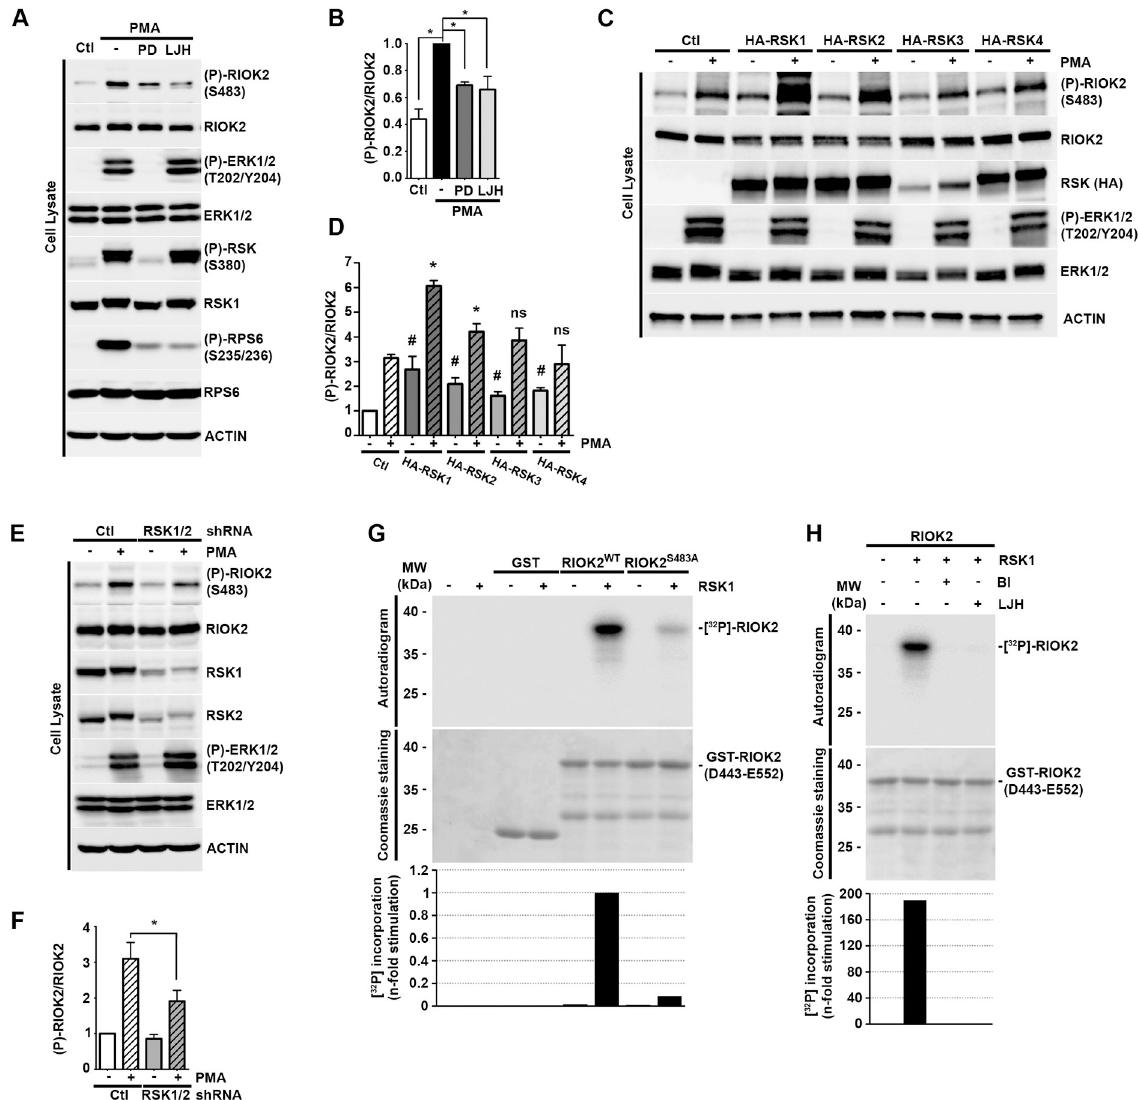
Fig 3. RIOK2 is a direct RSK substrate. (A) Serum-starved (Ctl) HEK293 cells were treated or not (-) with PD184352 (PD), or LJH685 (10 μ M) (LJH) for 1 h prior to PMA stimulation (100 ng/ml, 20 min). Phosphorylation of endogenous RIOK2 at Ser483 ((P)-RIOK2) was monitored by WB using specific antibodies. (B) (P)-RIOK2 and total RIOK2 signals obtained in (A) were quantified using ImageLab software and expressed as fold change relative to the PMA condition. Statistically significant differences are indicated by asterisks ( � : P � 0.05, One- tailed Mann Whitney test). (C) HEK293 cells were transfected with vectors over-expressing HA-tagged RSK1, RSK2, RSK3 or RSK4, or the empty vector (Ctl). Following serum-starvation and PMA stimulation (100 ng/ml, 20 min), samples were analyzed by WB using the indicated antibodies. (D) (P)-RIOK2 and total RIOK2 signals obtained in (C) were quantified using ImageLab software and expressed as fold change relative to starved Ctl cells. Statistically significant differences between starved conditions relative to starved Ctl cells are indicated by hashes, and between PMA stimulated conditions relative to stimulated Ctl cells by asterisks (#/ � : P � 0.05, ns: not statistically significant, One-tailed Mann Whitney test). (E) HEK293 cells expressing shRNA targeting an irrelevant sequence (Ctl) or both RSK1 and RSK2 (RSK1/2) were processed as in (C) . (F) (P)-RIOK2 and total RIOK2 signals obtained in (E) were quantified using ImageLab software and expressed as fold change relative to the starved condition. Statistically significant differences are indicated by asterisks ( � : P � 0.05, One-tailed Mann Whitney test). (G) Human activated RSK1 was incubated in the presence of γ [ 32 P]-ATP with either GST alone, or a GST-RIOK2 peptide (D443-E552) containing either S483 (RIOK2 WT ) or the non-phosphorylatable version (RIOK2 S483A ). The resulting samples were analyzed by SDS-PAGE and revealed by autoradiography or Coomassie blue staining. Quantification of [ 32 P] incorporation within each peptide is expressed as n-fold change compared to the absence of RSK1. (H) In vitro kinase assays performed as in (G) in the presence or not of RSK inhibitors BI-D1870 or LJH685 (10